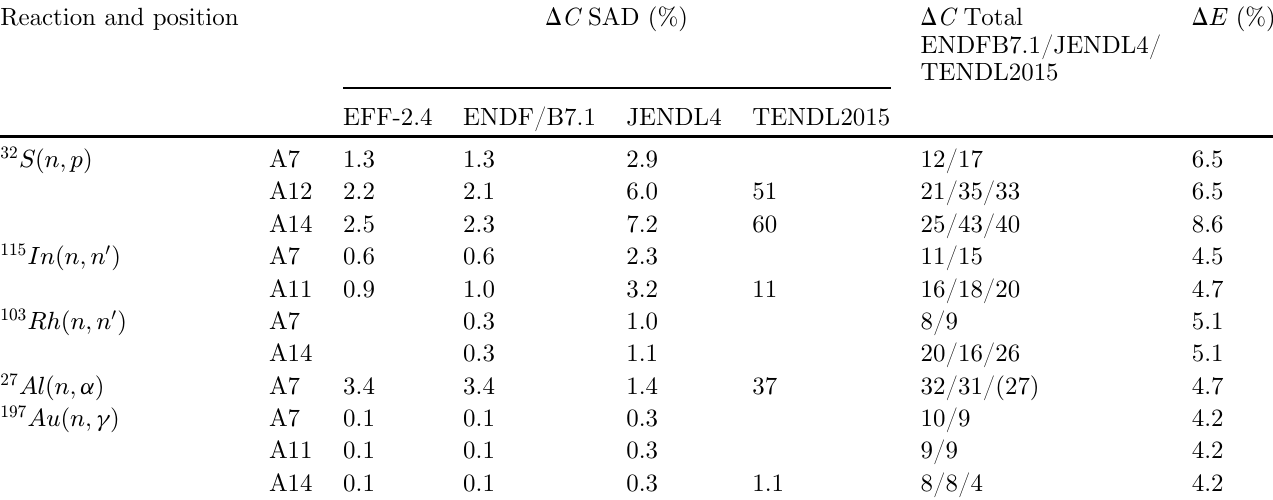
Table 3. ASPIS IRON-88 benchmark: computational ( D C ) vs. experimental ( D E ) uncertainties. Reaction and position D C SAD